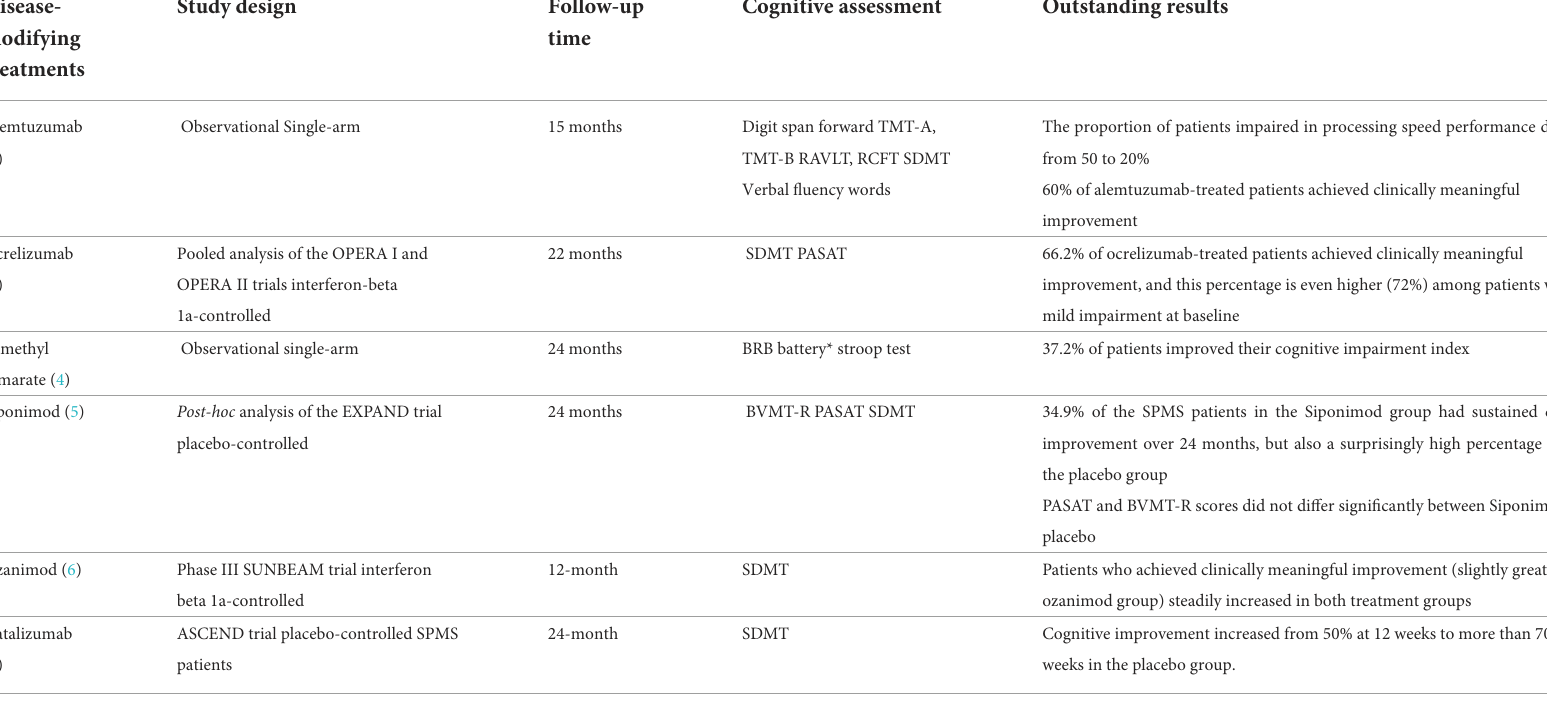
TABLE 1 Unreasonable results of studies analyzing the effects of disease-modifying treatments on cognitive